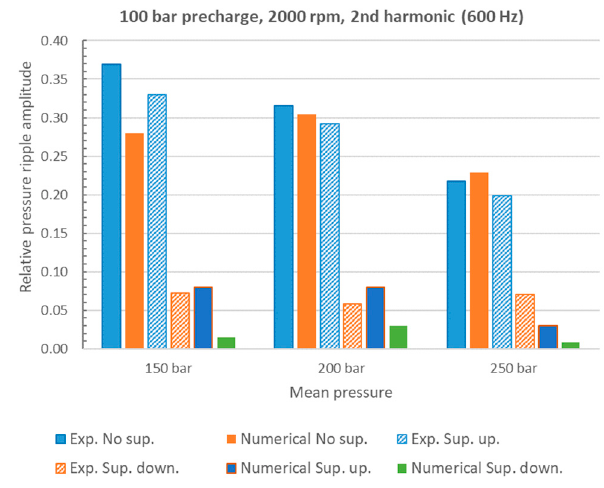
Figure 18. FFT of the pressure ripple, 2nd harmonic, pump speed = 2000 rpm.